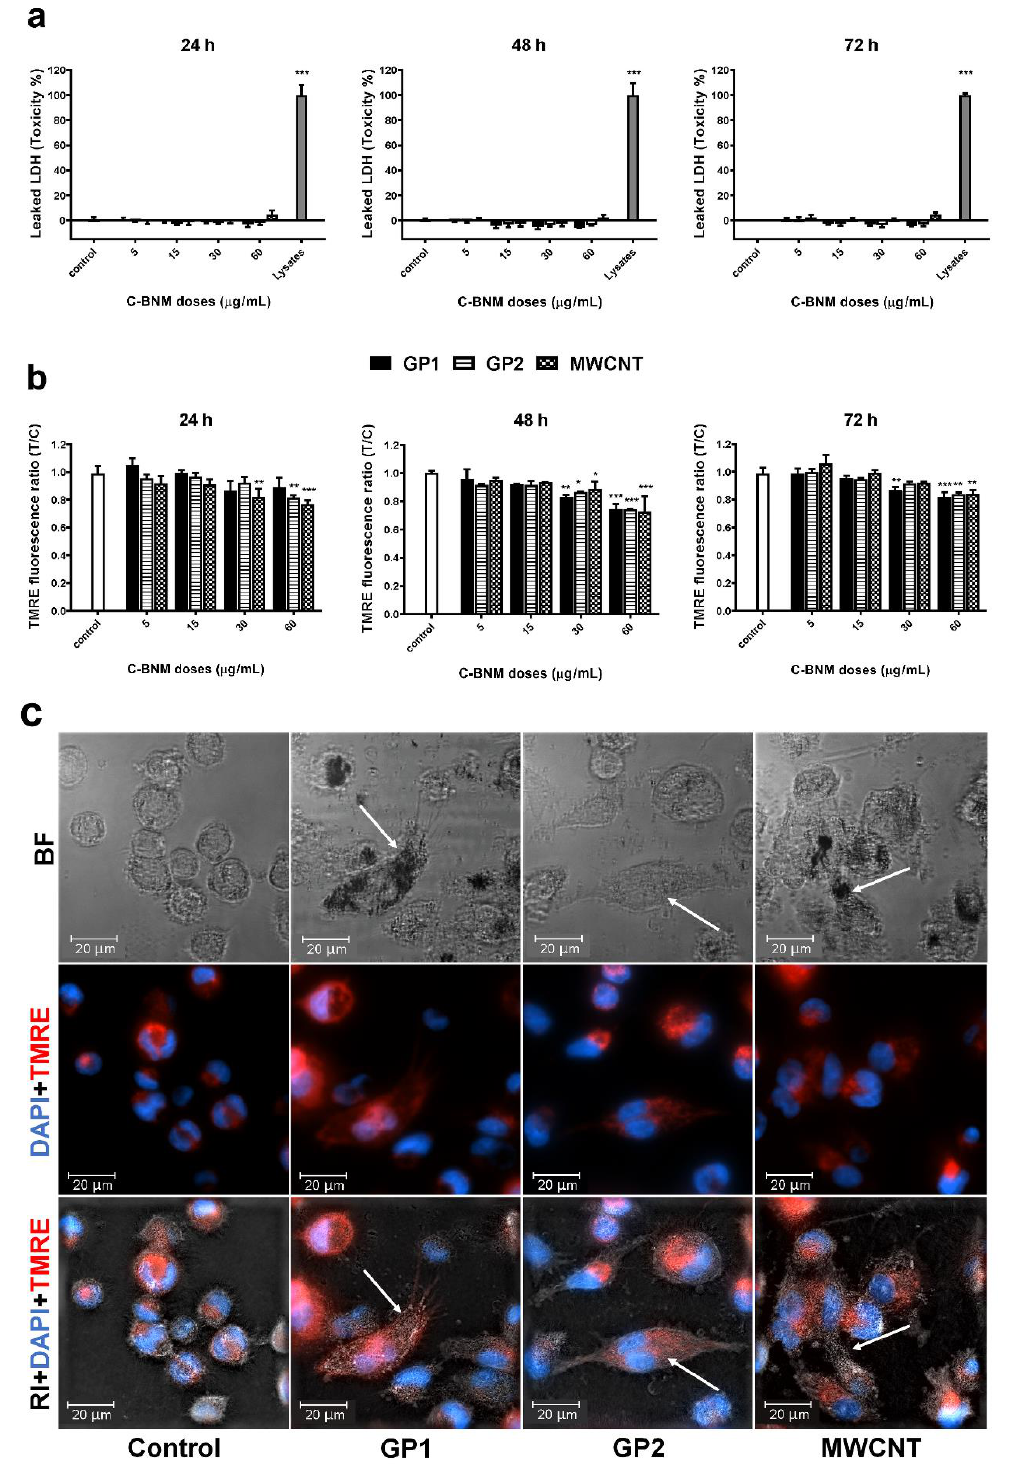
Figure 5. Cell responses to C-BNM: ( a ) Percentage of cytotoxicity via LDH assay after 24 h, 48 h and 72 h exposure. Data are reported as average ± standard error of the mean ( Toxicity % = (T – C) / (L – C) × 100 ); T —test cells; C —untreated control; L —lysates. The symbol *** p < 0.001 highlights statistical significance as compared to the corresponding C ; ( b ) mitochondrial potential via TMRE staining after 24 h, 48 h and 72 h exposure. Data normalised to control (untreated cells) represent an average ± standard error of the mean. The symbols * p < 0.05; ** p < 0.01; *** p < 0.001 highlight the statistical